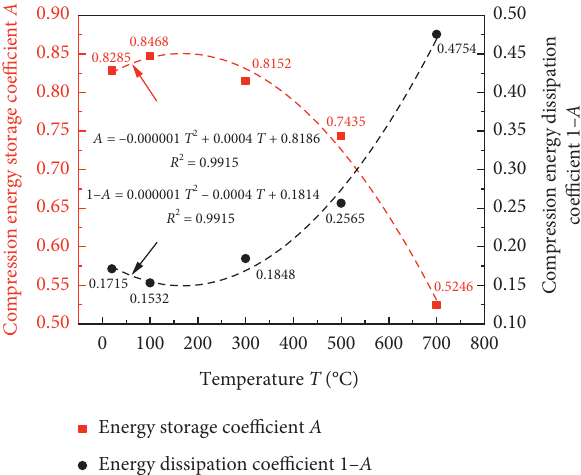
Figure 5: The variations of A and 1– A for pre-heated granite specimens [46].